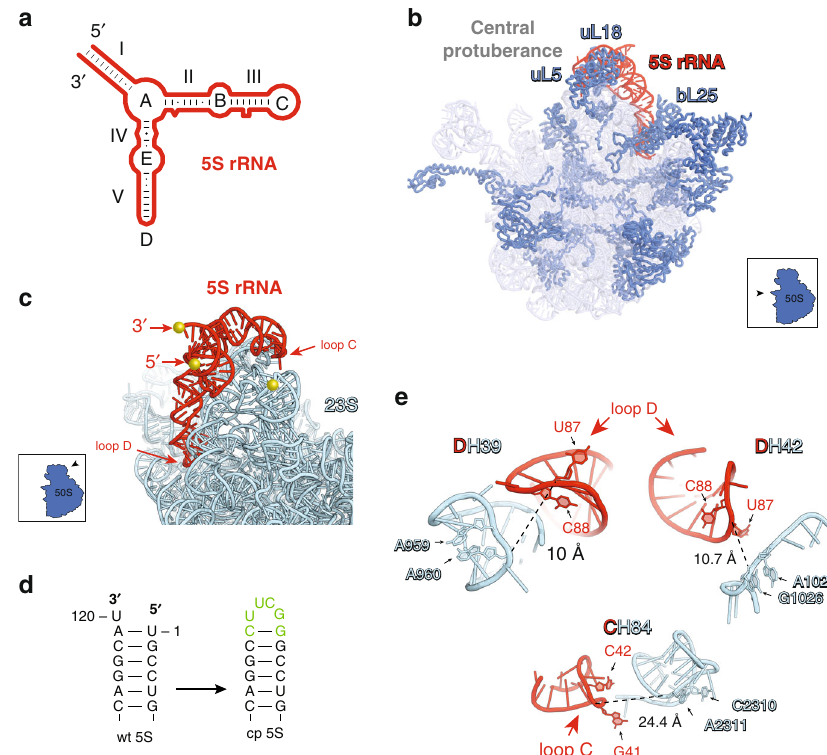
Fig. 1 5S rRNA in the ribosome. a Secondary structure of the 5S rRNA; RNA stems (I-V) and loops (A – E) are indicated. b The view of the E. coli 50S ribosomal subunit from the interface side (PDB 4YBB 7 ). 5S rRNA is shown in red, 23S rRNA is light blue and r-proteins in dark blue. c Interactions between wt 5S rRNA and 23S rRNA (as seen from the large subunit solvent side). The native ends of the 5S rRNA and the nearest accessible 23S rRNA site are marked by golden spheres. Loops C and D, which are in a close proximity to 23S rRNA, are indicated. Proteins are removed for clarity. d Engineering cp5S rRNA by linking its native ends with a tetra-loop. The altered/added residues are in green. e The cp5S rRNA integration sites. The shortest distances between the nucleotide phosphates of the 5S rRNA and 23S rRNA are indicated by dotted